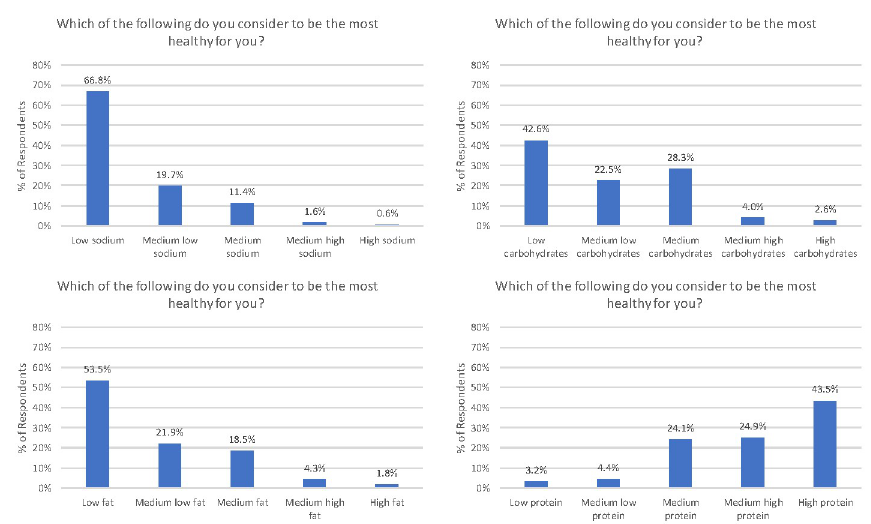
Fig 4. Perception of healthiness of sodium, carbohydrates, fat, and protein ( sampling error for each statistic is ±2 . 7% . )